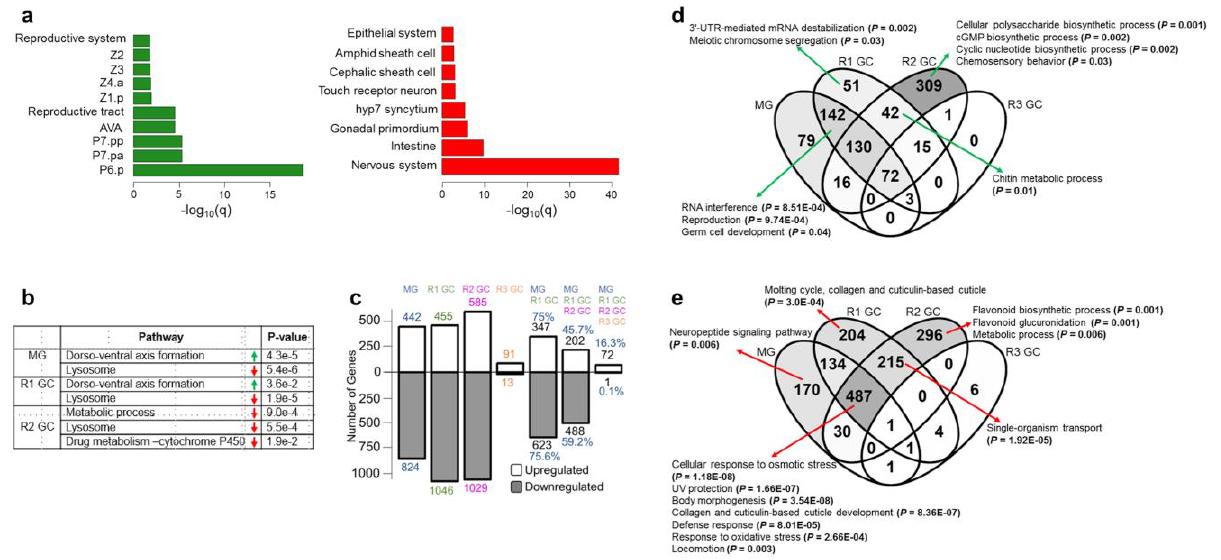
Figure 2. Differentially expressed gene profiles under simulated microgravity and after return to ground conditions. ( a ) Tissue enrichment of the upregulated (green) and downregulated (red) genes under simulated microgravity. ( b ) Pathway enrichment of the upregulated (green) and downregulated (red) genes during the exposure to simulated microgravity (MG), and four and eight days after return to ground conditions (R1 GC and R2 GC, respectively). ( c ) The number of differentially expressed genes under simulated microgravity and the transmission of the differential expression after return to ground conditions. ( d ) Categorization of the upregulated genes in comparison to the ground control animals, and the enriched gene ontology terms assigned to them. ( e ) Categorization of the downregulated genes in comparison to the ground control animals, and the enriched gene ontology terms assigned to them.